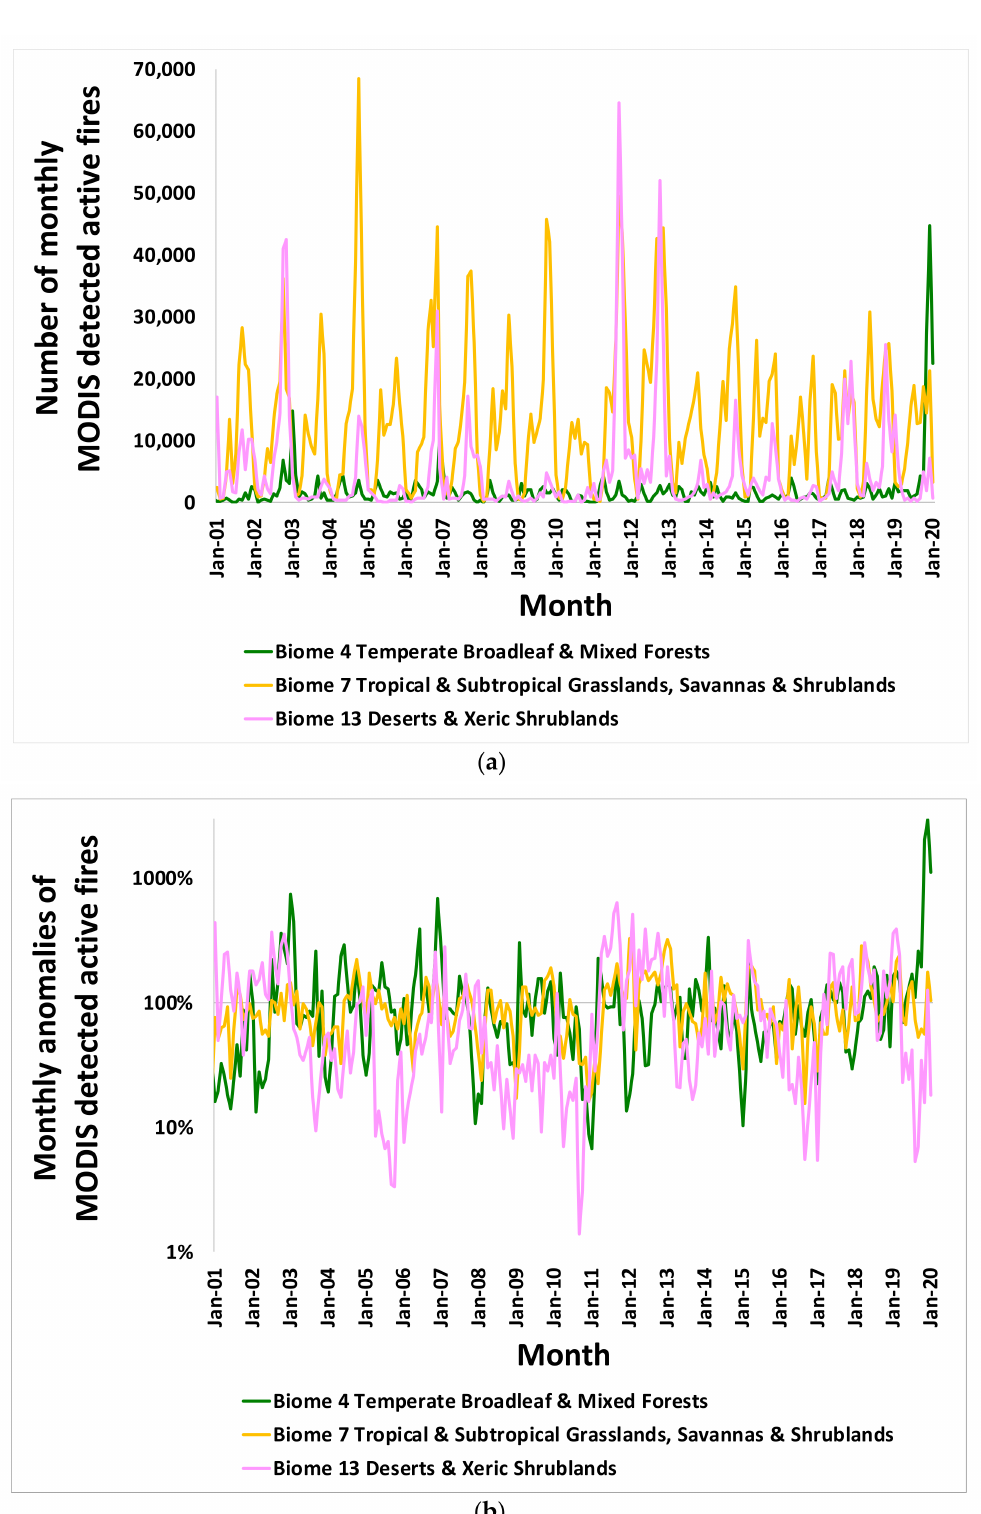
Figure 4. Monthly numbers of MODIS-detected active fires between January 2001 and January 2020, classified by WWF biome ( a ); monthly anomalies of MODIS-detected active fires, classified by WWF biome (compared with the average monthly number between 2001 and 2018 ( b ); the figure only includes the three biomes where, overall, most fires in Australia occur). The labels on the x -axis stand for the month of January in the years 2001 to